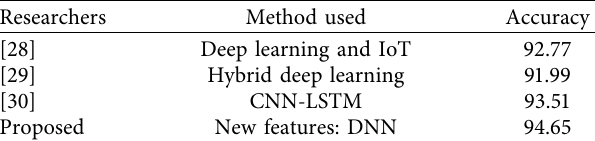
Table 4: Accuracy of the proposed method compared with existing